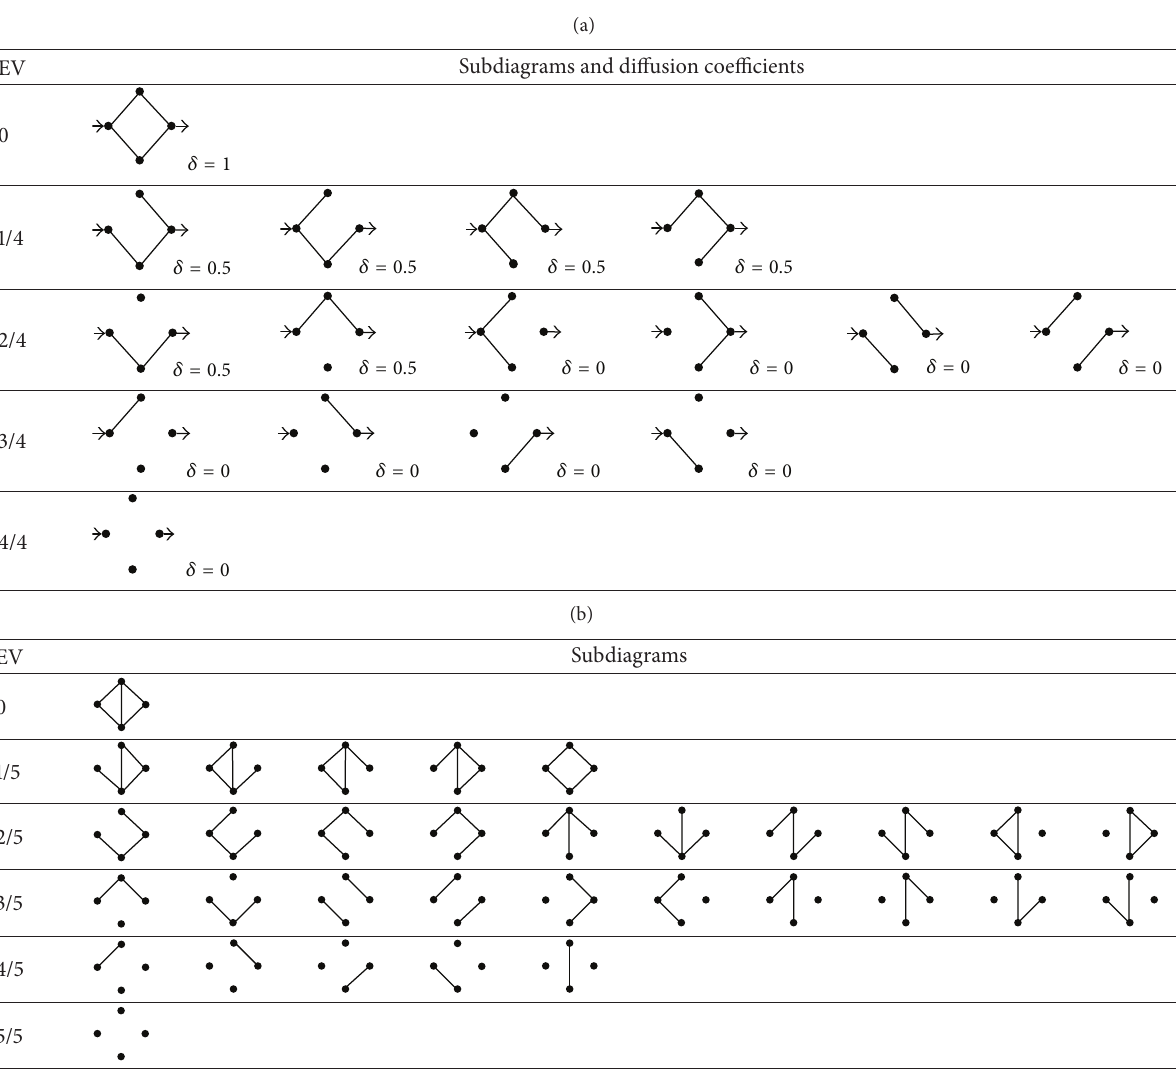
Table 5: (a) All the subdiagrams obtained from the model of Figure 2(a) by gradual elimination of the four transitions. EV: excluded volume resulting from the elimination of 0, 1,. . . , 4 transitions ( 0,1/4, .. ., 4/4 ). The figure includes the value of the diffusion coefficient of each subdiagram for the case that 𝜆 and all the rate constants equal 1. (b) All the subdiagrams obtained for the model of Figure 1(a) by gradual elimination of the five transitions. EV is as in Table 5(a), but for five